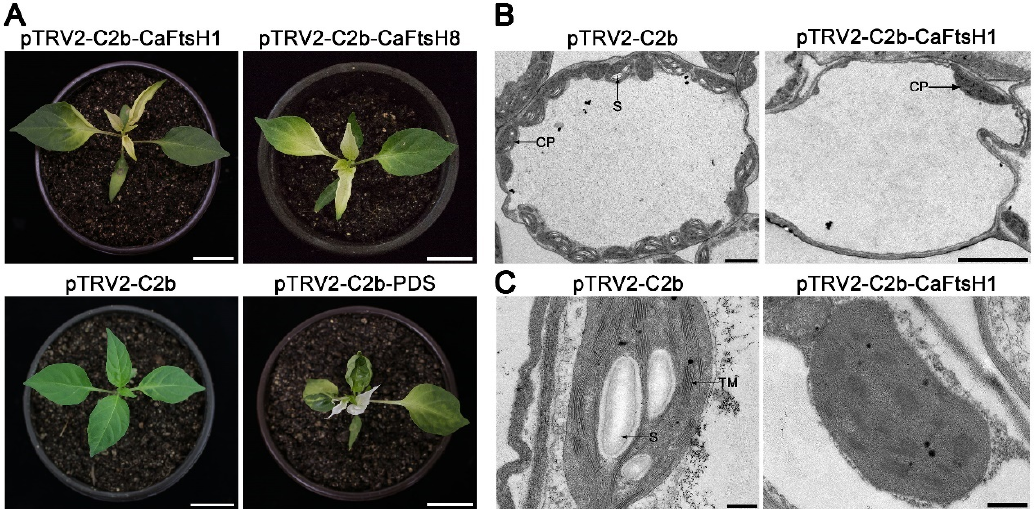
Figure 5. Phenotype and chloroplast ultramicrostructure observation of gene silenced plants via the VIGS system. ( A ) Phenotypes of representative individuals of pTRV2-C2b-CaFtsH1 and pTRV2-C2b-CaFtsH8-positive plants, and their positive (pTRV2-C2b-PDS) and negative (pTRV2-C2b) controls. ( B , C ) Transmission electron micrographs of chloroplasts in negative control and CaFtsH1- silenced plants. S-starch grains, CP-chloroplast, and TM-thylakoid membrane. Bars: ( A ) 3 cm; ( B ) 3 µ m; ( C ) 500 nm.